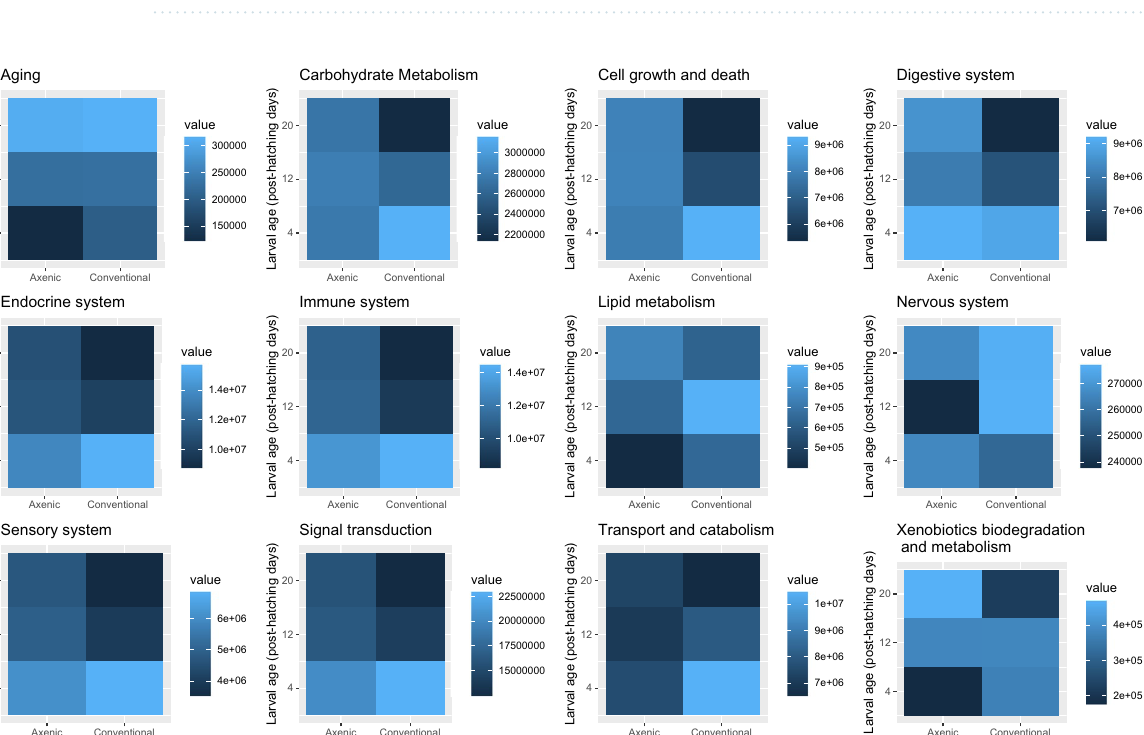
Table 1. Annotated DETs persistently upregulated.